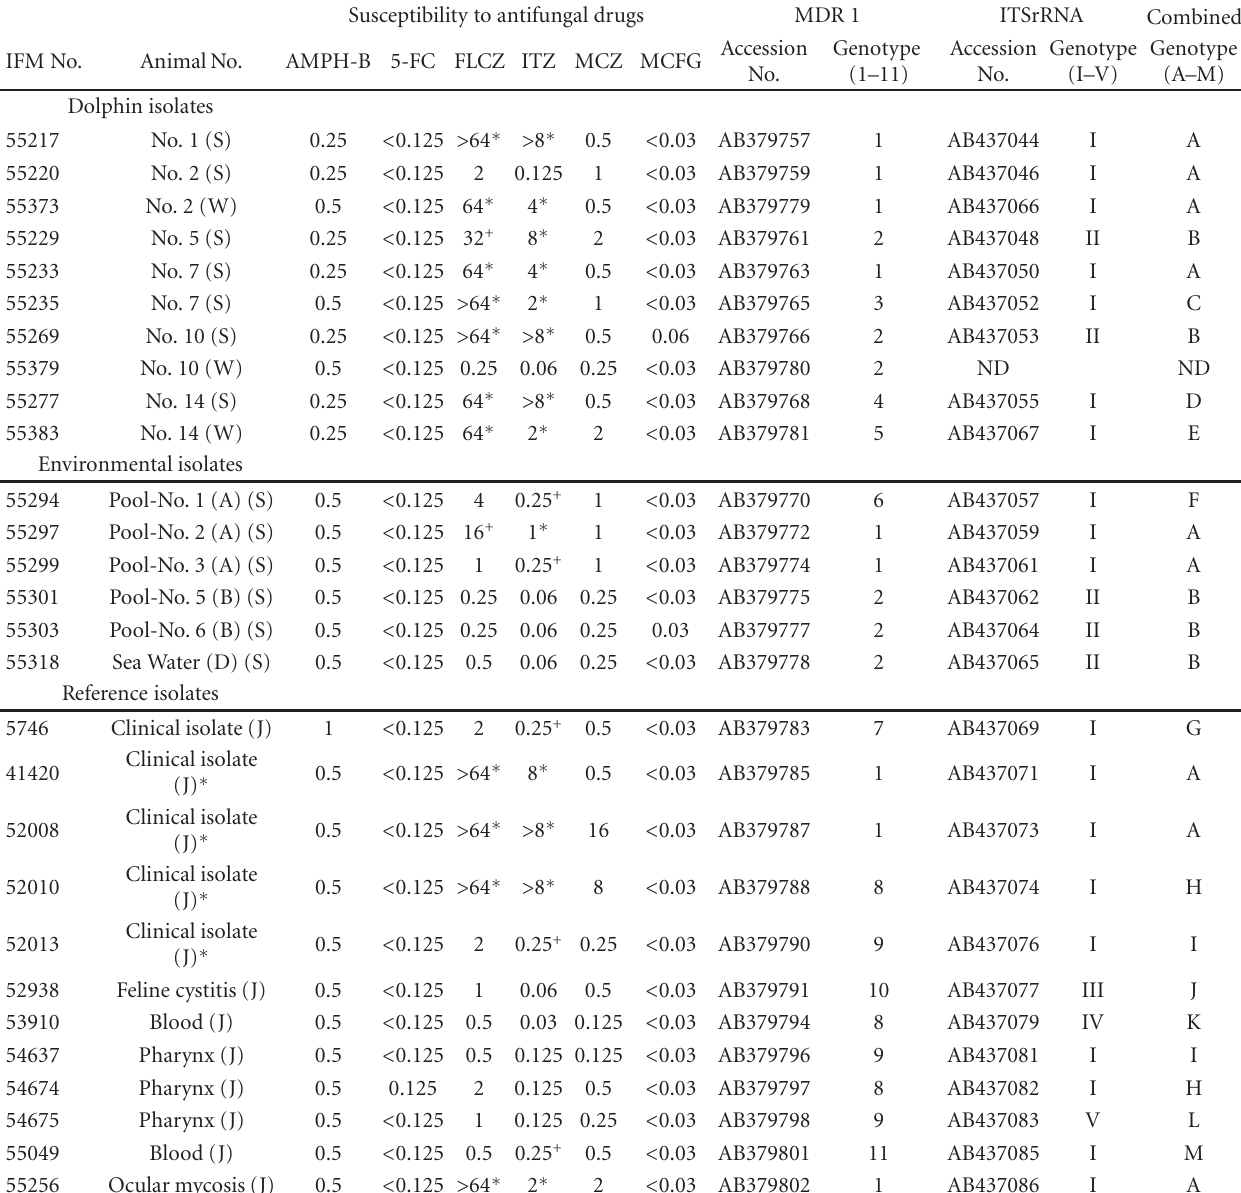
Table 6: Antifungal susceptibility and genotypes of C . tropicalis